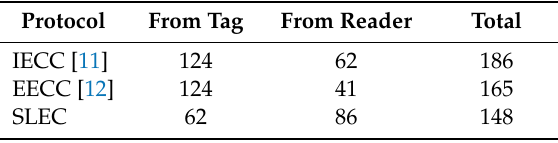
Table 5. Comparison of communication cost. Protocol From Tag From